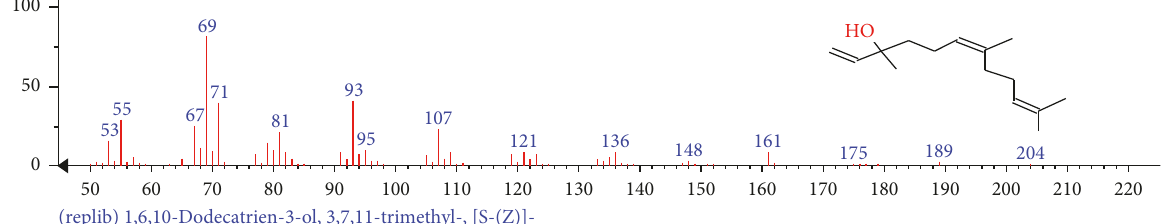
Figure 30: Mass spectrum of compound 1,6,10-dodecatrien-3-ol, 3,7,11-trimethyl-, [S-(Z)]- of whole plant hexane fraction of Achillea wilhelmsii (WHFAW).